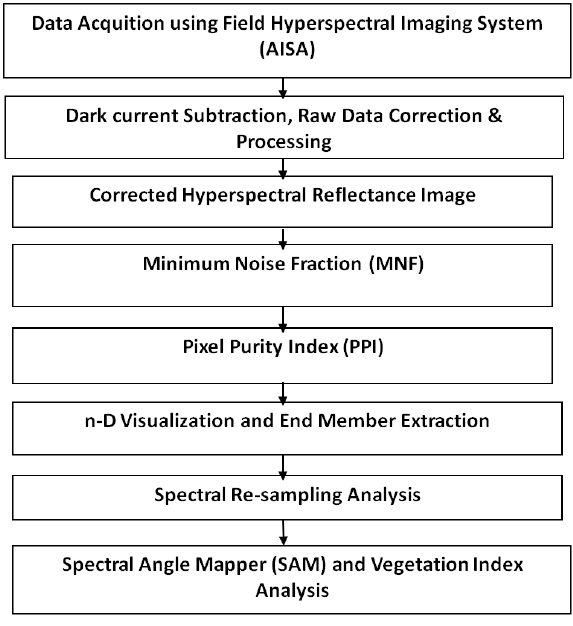
Fig.2. Methodology Flow Chart